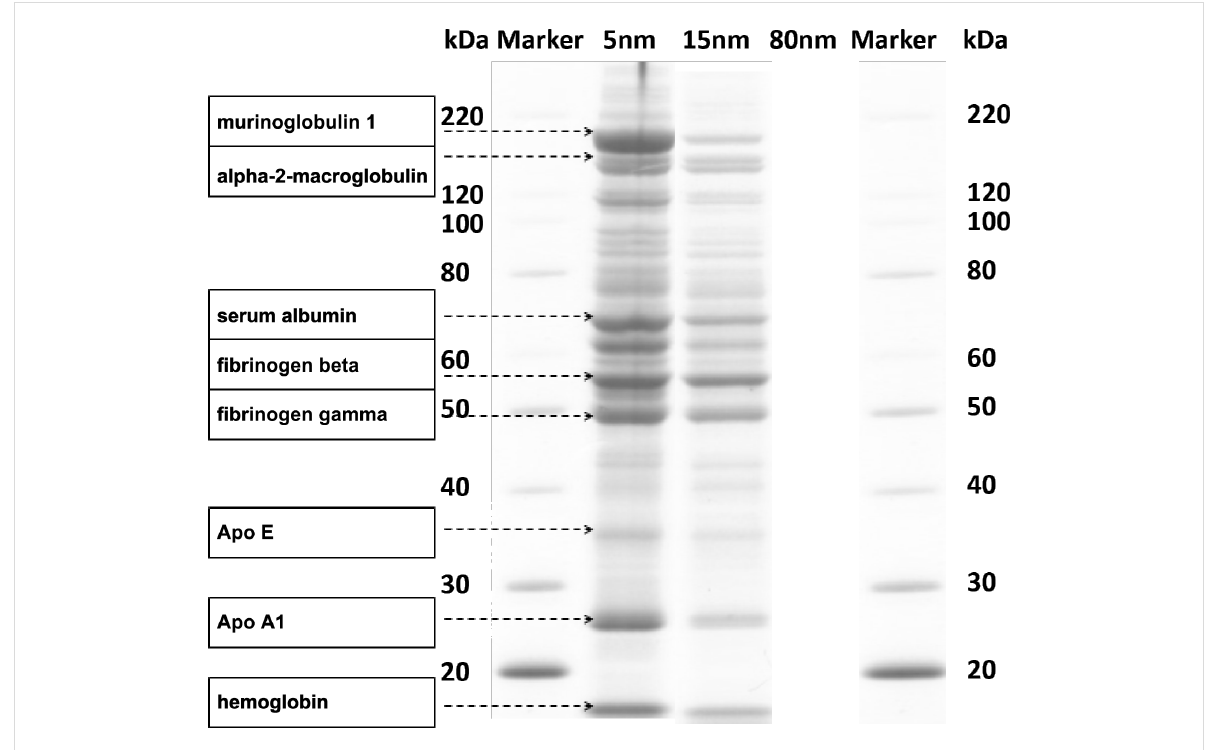
Figure 2: The size-selective separation of mouse serum proteins in the corona of the three differently sized AuNP are shown in the different gel lanes (after incubation and washing). Molecular weights (kDa) derived from the marker proteins are given at the left and right side. Labeled proteins were identified by MALDI–TOF MS. The number of bands and quantitative amount of adsorbed proteins differed between 5, 15 and 80 nm AuNP. Band in- tensities of adsorbed proteins decreased with increasing AuNP sizes. Reproduced with permission from [7]. Copyright 2013 IOP Publishing.